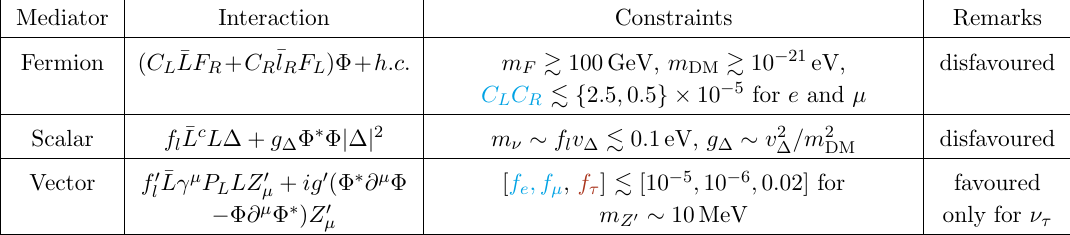
Table 5. Summary of renormalisable neutrino-DM interactions. Colour coding is the same as in table 4.